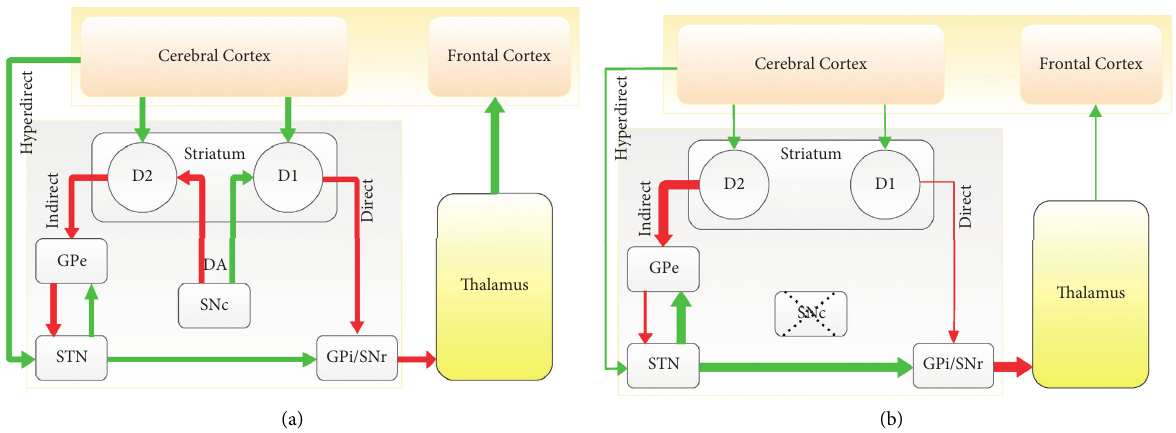
Figure 1: Schematic illustration of the CBGTC loop. The classical model of the BG consists of the opposing direct and indirect pathways. The hyperdirect and DAergic pathways are also shown. (a) CBGTC loop in the normal state. (b) CBGTC loop in the PD state characterized by loss of DA and alteration of inputs. Green and red arrows represent excitatory and inhibitory inputs, respectively. Thickness of arrows indicates the strength of